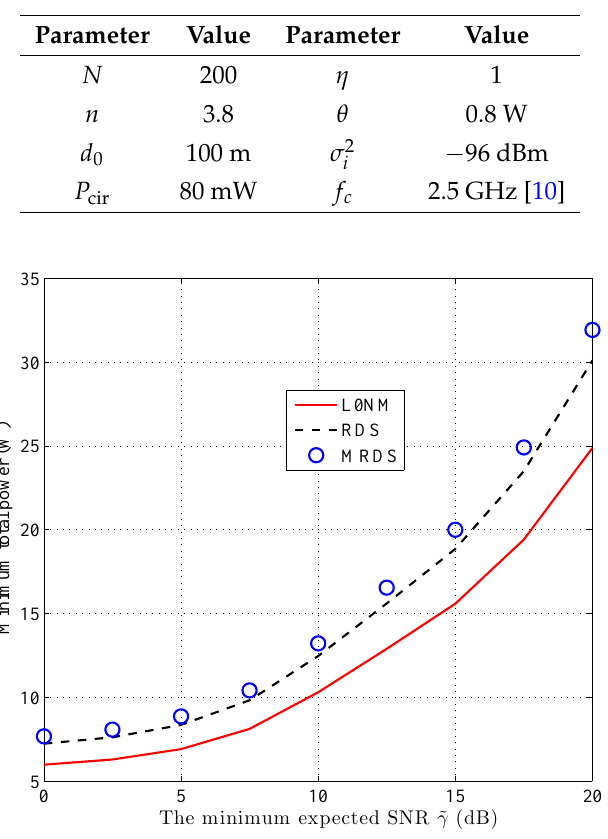
Figure 1. The orthogonal probability ( δ = 0.2) versus the number of base station (BS) antennas. Table 1. Simulation Parameters.